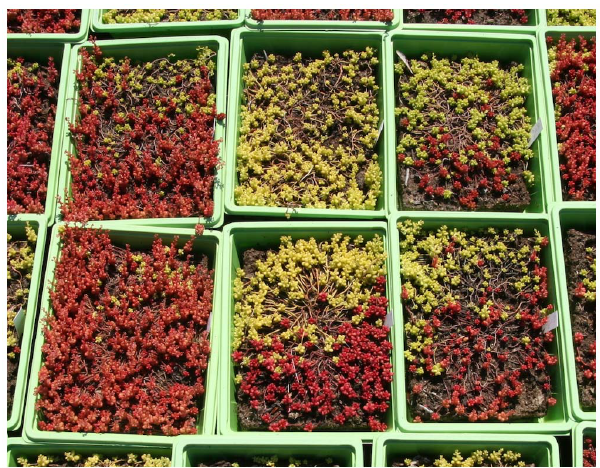
Figure 2. Plants of Sedumalbum used in the present study. Each tray contained one or two genotypes, in the latter case differing in anthocyanin production to allow separation between genetically different individuals. Photo taken in the summer of 2007.